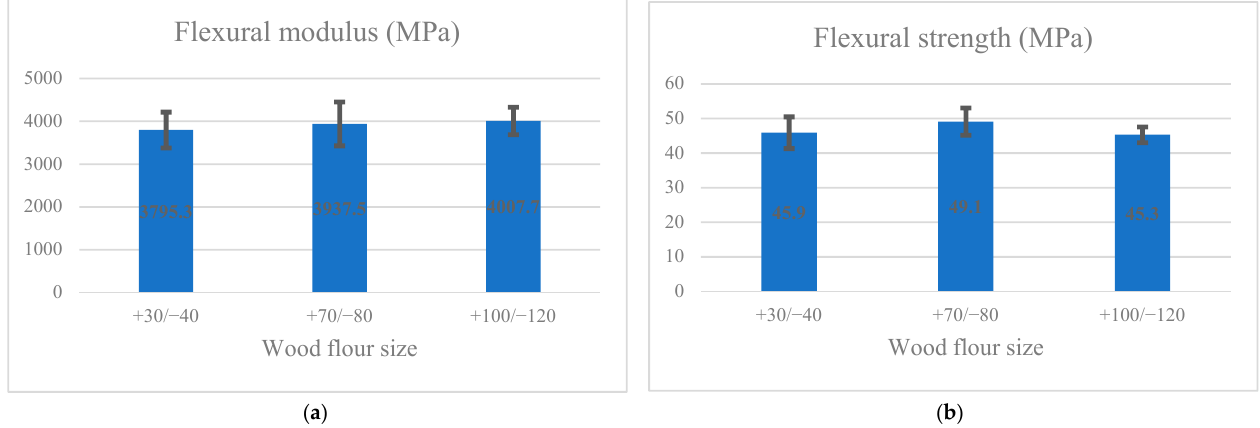
Figure 4. Impact of wood flour size on flexural ( a ) modulus; ( b ) strength. Figure 5 presents the effect of wood flour size on impact energy. The highest impact energy was obtained for wood flour with dimensions of +30/ − 40 powder size. The impact energy was lowest for the +100/ − 120 mesh.